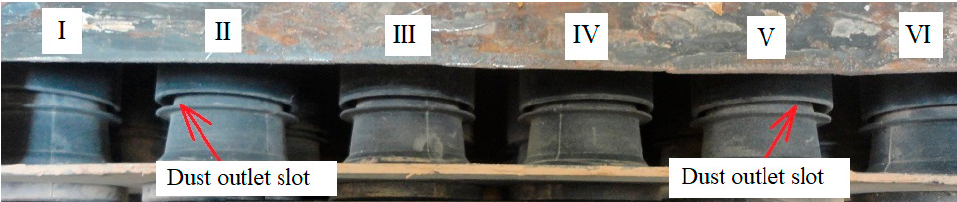
Figure 15. The view of the multi-cyclone from the dust suction collector. Visible outlet slots of the cyclones before starting operation by the multi-cyclone (I, II, III, ... VI—cyclone serial number in the column).